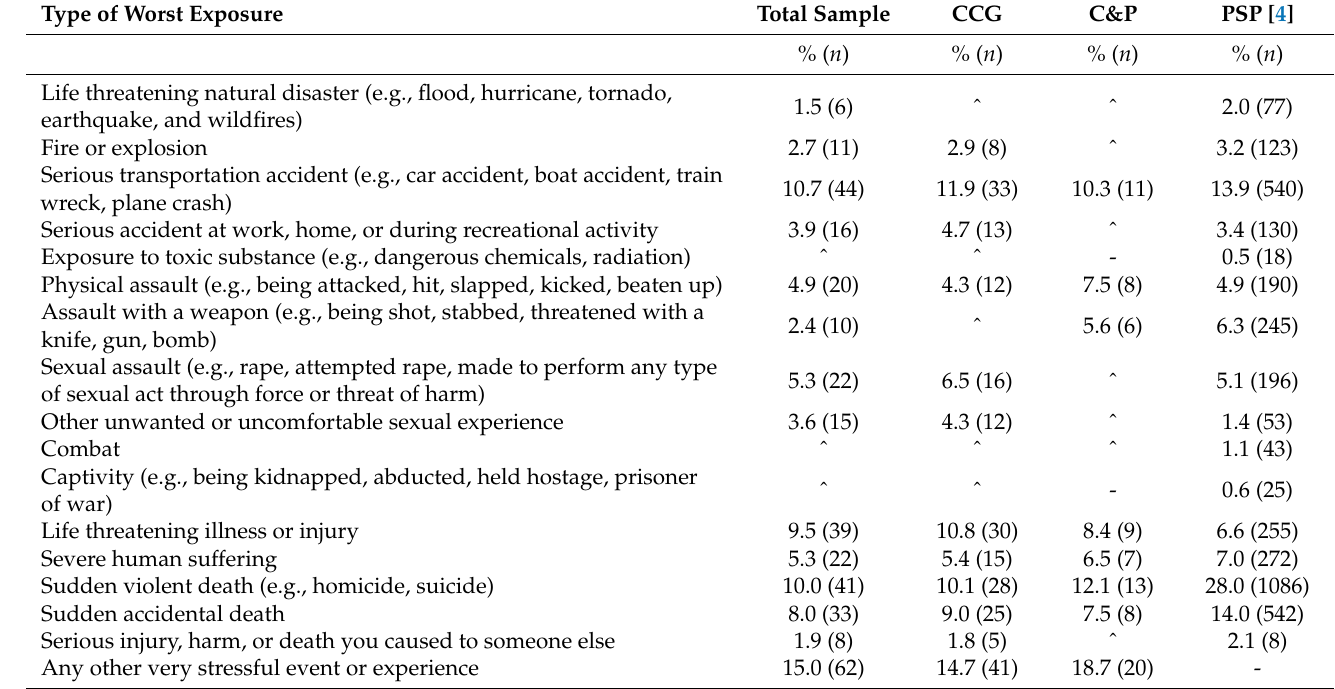
Table 4. Prevalence of Worst Potentially Psychologically Traumatic Events (PPTEs) Exposure Types CCG, C&P, and Previously Published PSP.